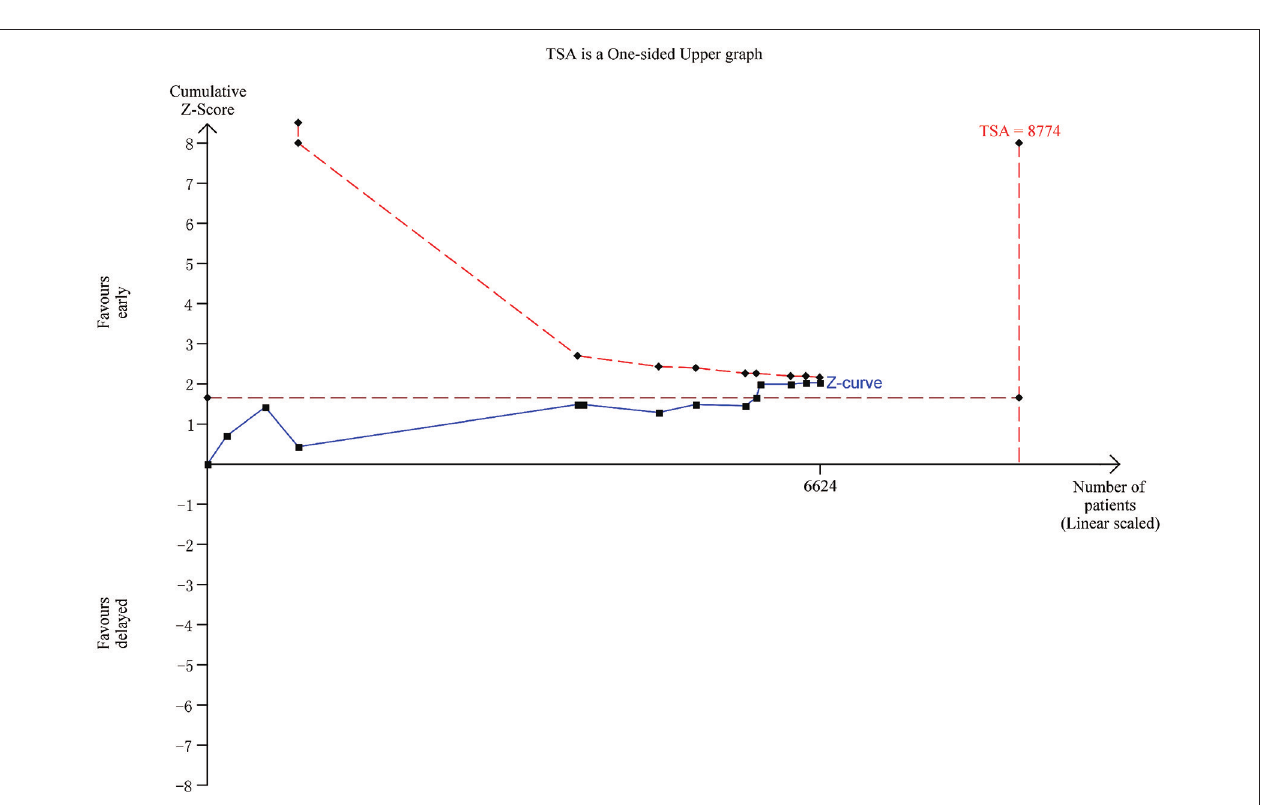
FIGURE 8 | TSA plot for the comparison assessing mortality rate between early ( < 24h) and delayed invasive